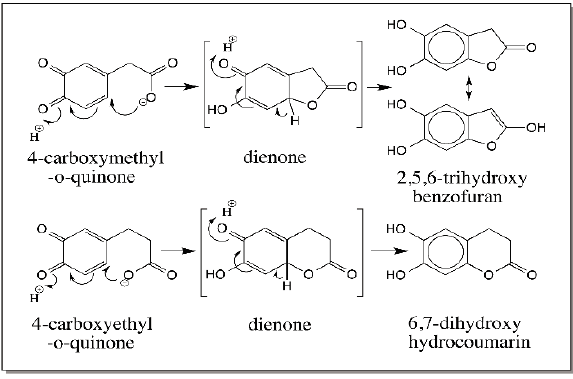
Figure 3. Nucleophilic addition of internal carboxyl group on quinone. Both carboxymethyl- o -quinone and carboxyethyl- o -quinone exhibit rapid intramolecular cyclization due to the presence of suitably substituted internal carboxyl group yielding cyclic products.